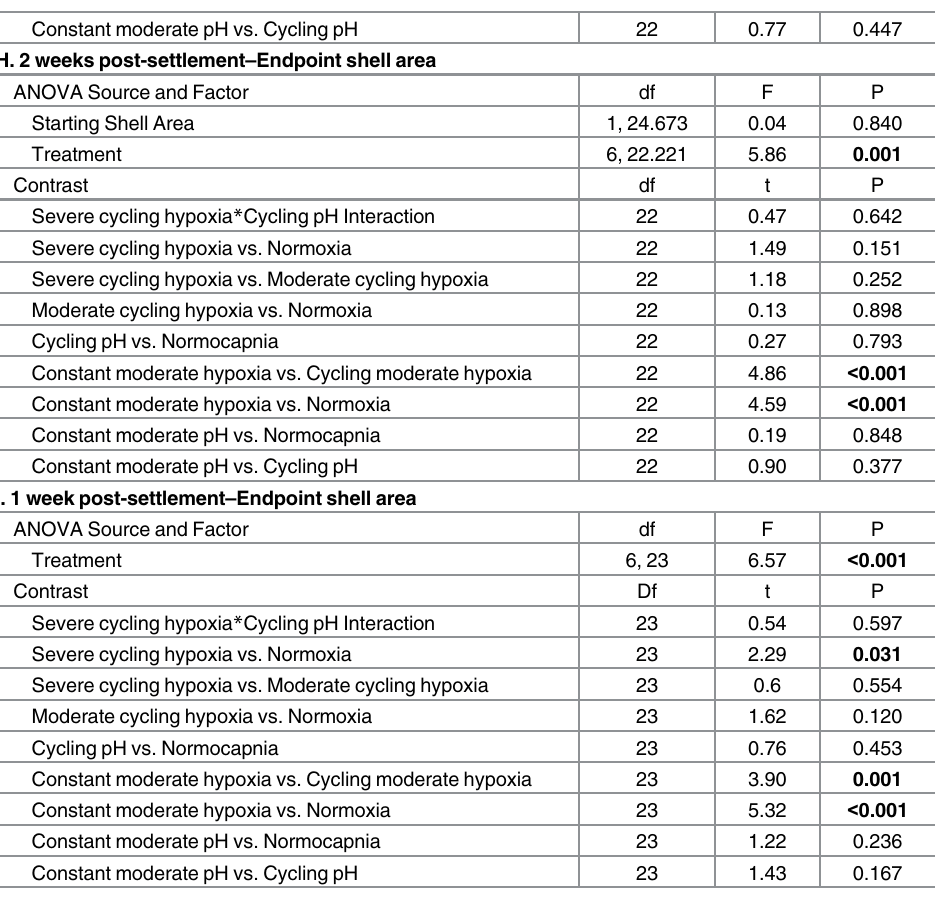
Randomized complete block design ANCOVA of instantaneous rate of growth in shell heights showing results from two age classes of juvenile oysters; (A) 4 weeks post-settlement, (B) 2 weeks post-settlement during fi rst 18 days of experiment. (C) ANOVA for 18 day shell area of juvenile oysters from 1 week post- settlement oysters. (D, E, F) ANCOVA of instantaneous growth rate during second half of experiment in three age classes of oyster. (G, H), ANCOVA of shell area at the end of the 5.5-week laboratory exposure using starting shell areas as a covariate in the two older age classes of juvenile oyster. ANOVA of (I) ending oyster sizes from settlement 3:1 week post-settlement during 39 day experiment. Tests are considered signi fi cant at a = 0.05 and signi fi cant p values are